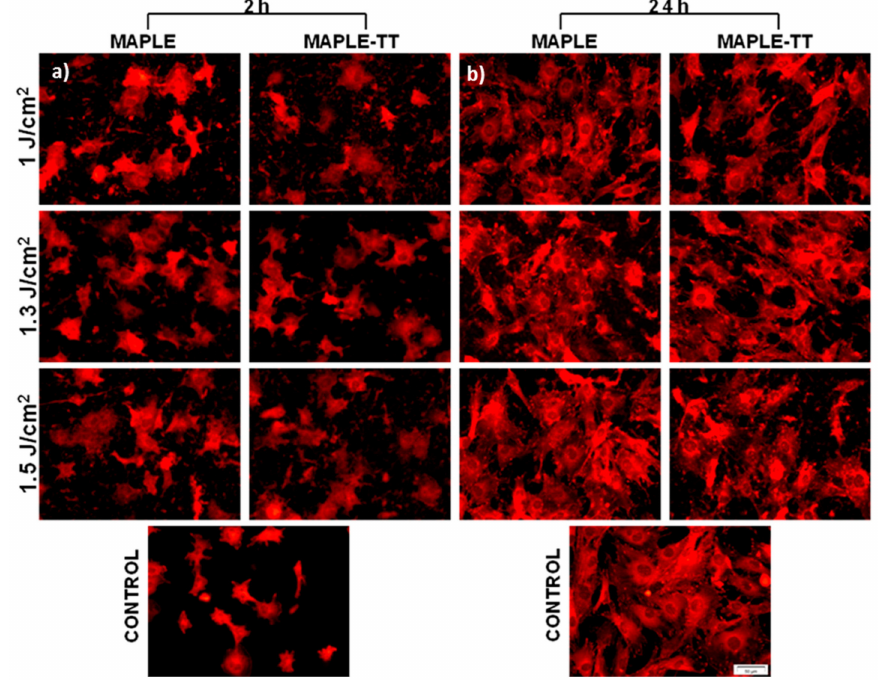
Figure 6. Immunofluorescence staining of vinculin (red) in MC3T3-E1 osteoblasts after 2 h ( a ) and 24 h ( b ) of culture onto di ff erent MAPLE and MAPLE TT-deposited PVDF materials. The controls were obtained on glass